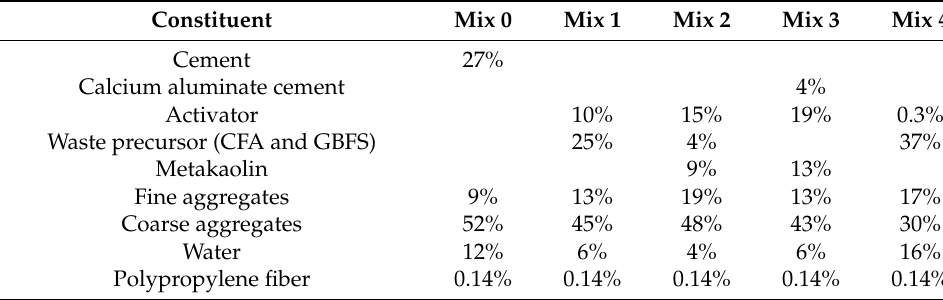
Table 3. Proportions of the different material mixes.